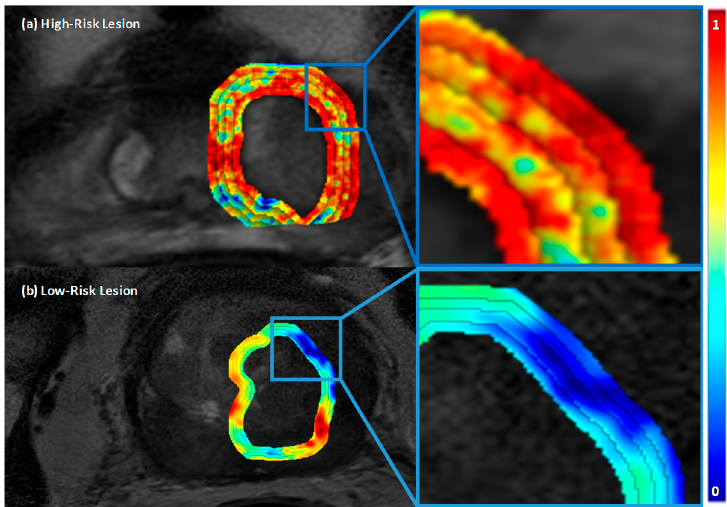
Figure 1. T2W MRI of a high risk and a low risk lesions ( left ) with their corresponding CoLlAGe entropy heat maps overlaid on the peri-tumoral (0–12 mm) regions ( right, inset).